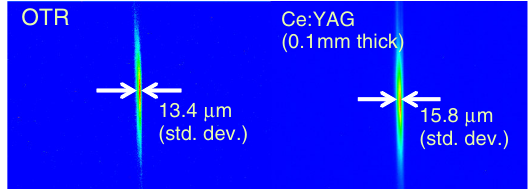
FIG. 10. Observed beam images of the SCM in an experiment at the SCSS test accelerator. (Left) The case of the OTR stainless-steel screen. (Right) The Ce:YAG fluorescence screen.